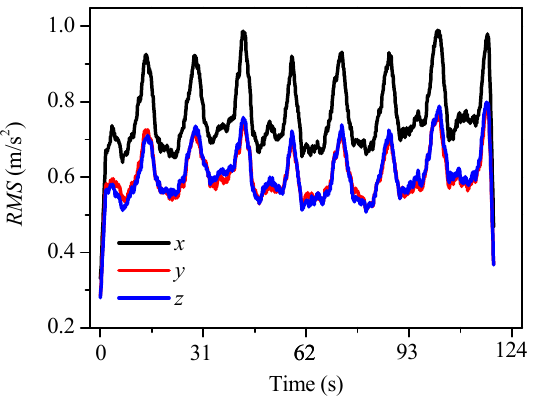
Figure 3. Cutting vibration MARMS values of each rotation.